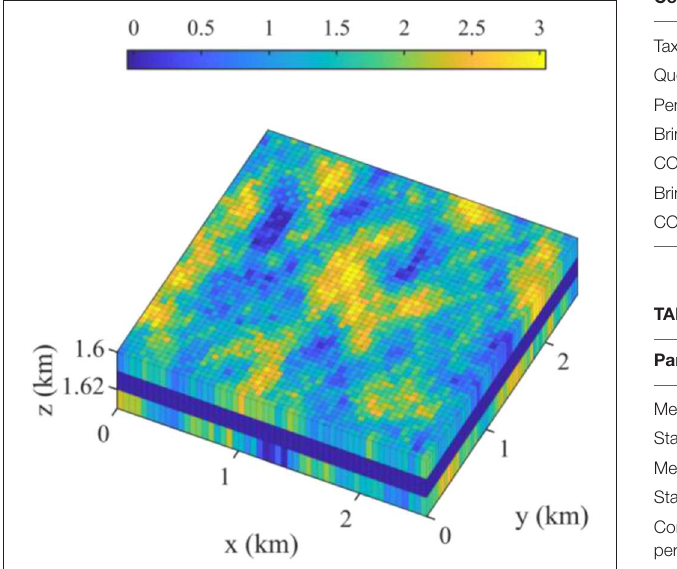
FIGURE 3 | Three-dimensional view of log 10 permeability (md). The z -axis is exaggerated by a factor of 20.